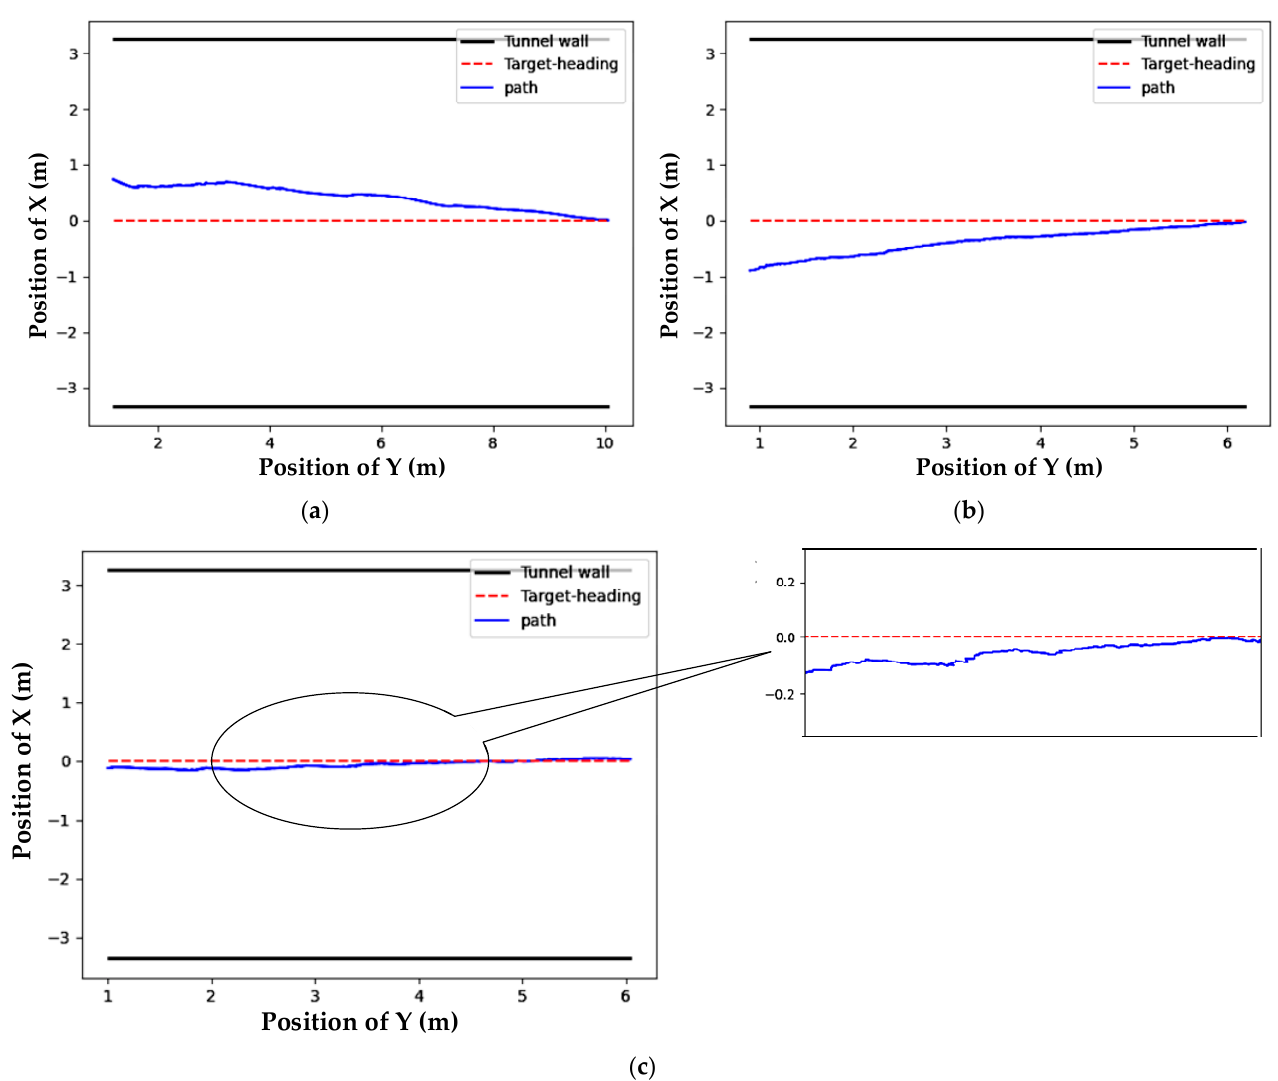
Figure 12. Path curve graph of UUV in simulation environment: ( a ) path curve of UUV in case Ⅰ ; ( b ) path curve of UUV in case Ⅱ ; and ( c ) path curve of UUV in case Ⅲ .